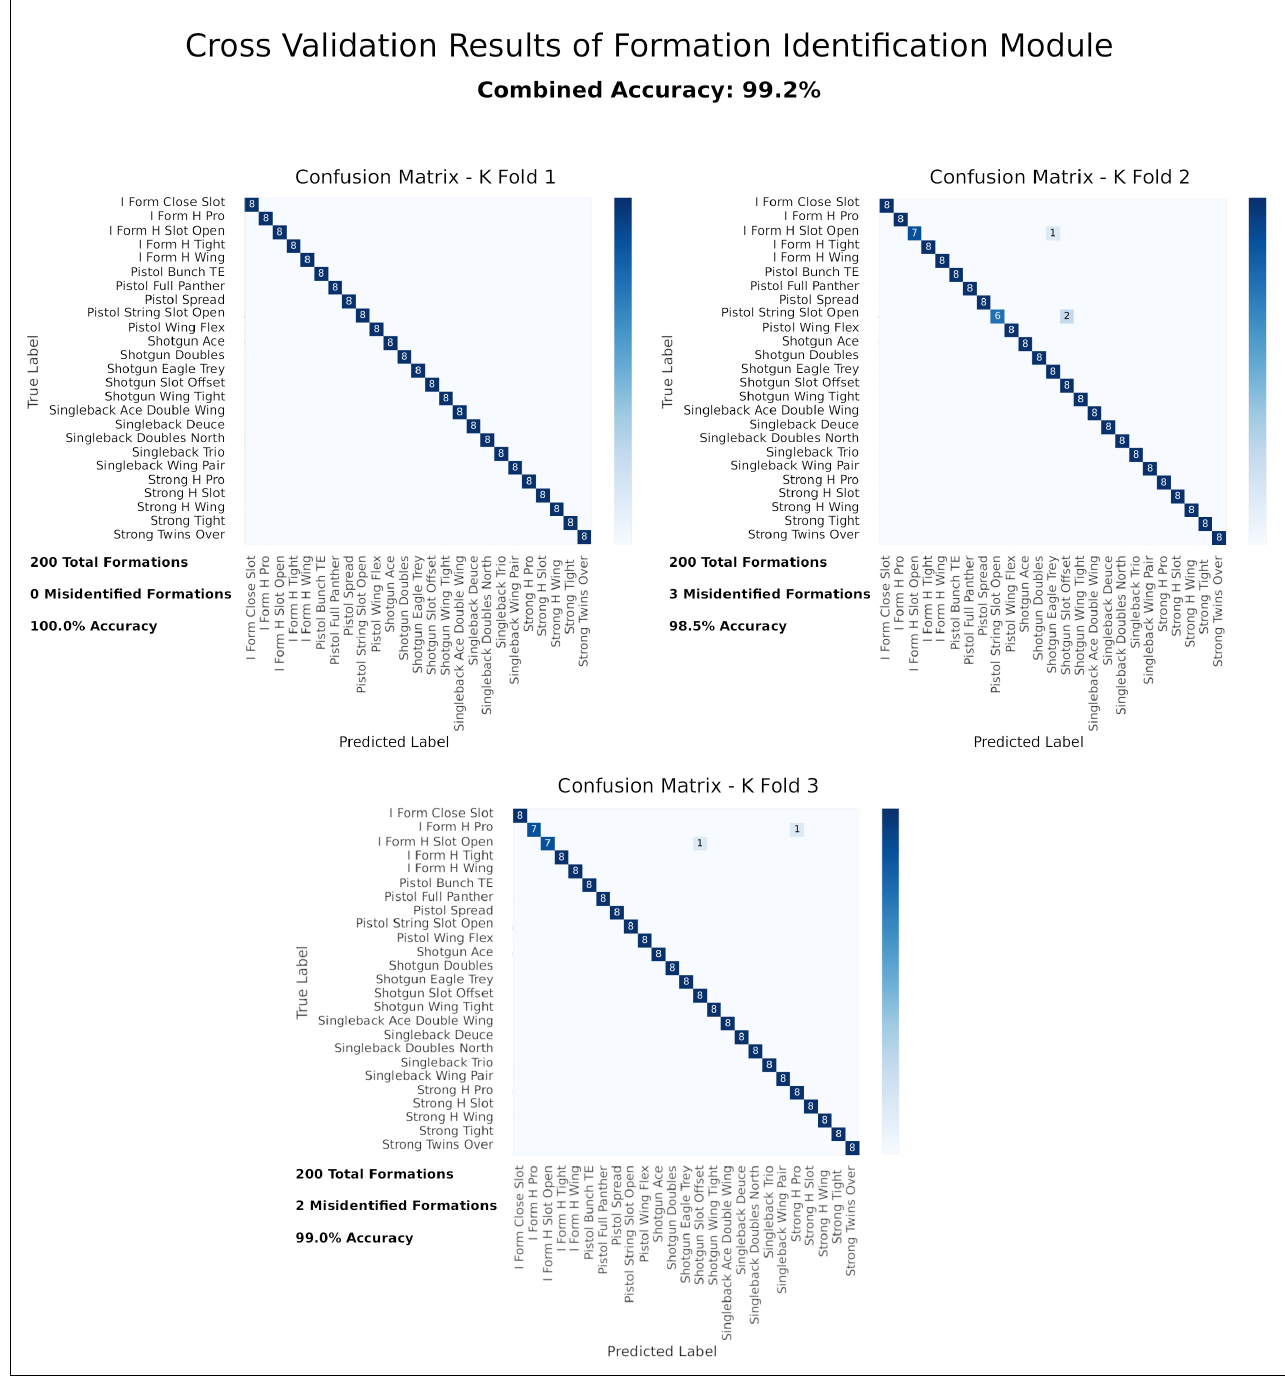
Figure 20. Cross-validation results of formation identification module—the combined accuracy of the three-fold cross-validation split is 99.2% with a standard deviation of